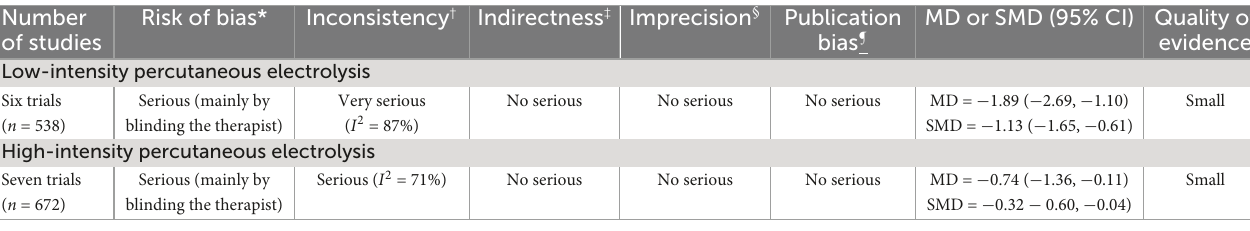
TABLE 3 GRADE evidence for percutaneous electrolysis to treat pain for musculoskeletal pain conditions. Number of